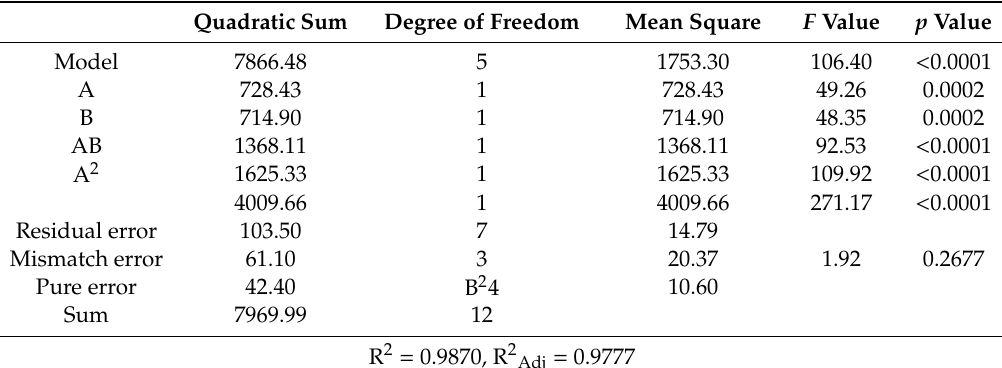
Table 4. Variance analysis of regression model.